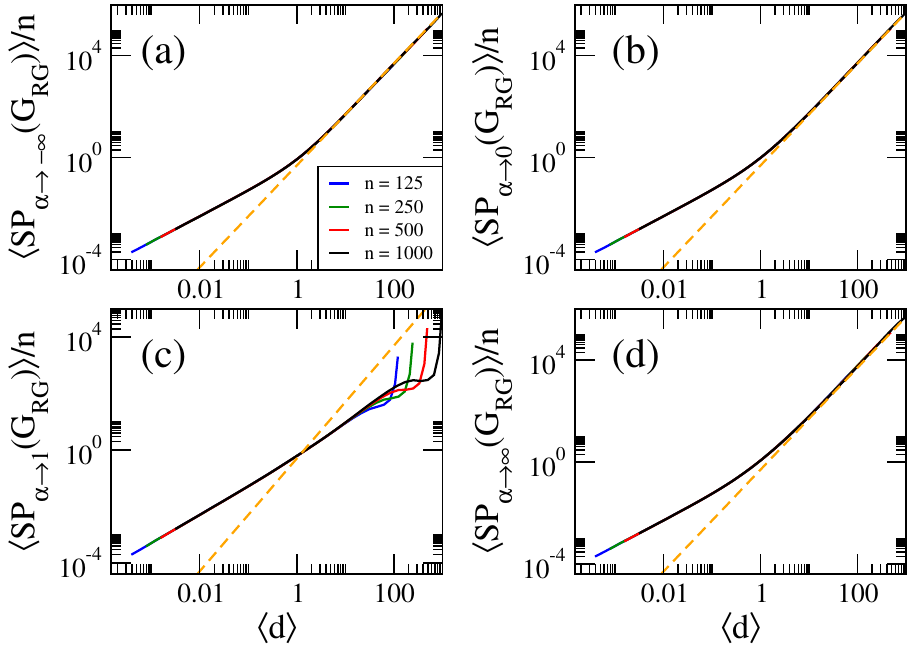
Figure 4: Average value of the Stolarsky–Puebla index (cid:104) SP average degree (cid:104) d (cid:105) of random geometric graphs. Same curves as in Figure 3. Orange dashed lines are (15). The vertical magenta dashed lines indicate (cid:104) d (cid:105) = 10